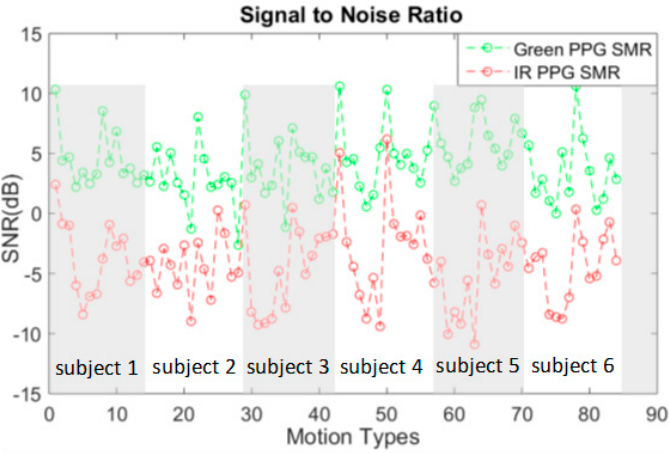
Figure 4. The SMR of green and IR PPG in different motion types among six subjects.